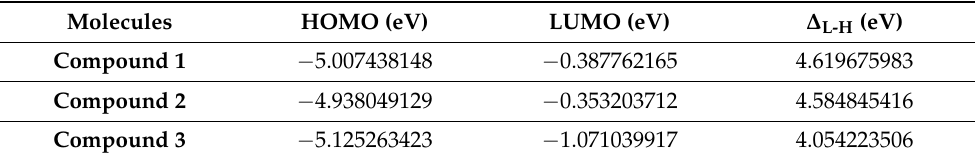
Table 2. Calculated energy levels of frontier molecular orbital (HOMO and LUMO), and the energy gaps ∆ L-H of the three studied